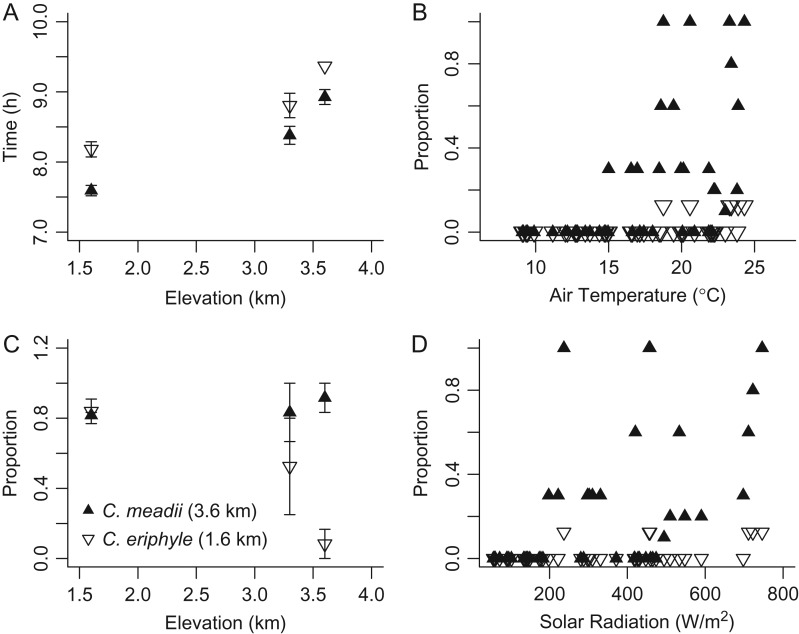
Reciprocal transplants between Colias meadii and Colias eriphyle show the proportion of butterflies that initiated flight (mean ± SEM; A) and the time at initiation (hour, mean ± SEM; C) for each population as a function of the elevation (in metres) of the observation site. To show how air temperature and direct solar radiation determine these proportions, we selected a representative day (26 July 2011) at Mesa Seco (3.6 km) and show the proportion initiated at a given air temperature (B) and level of direct solar radiation (D).